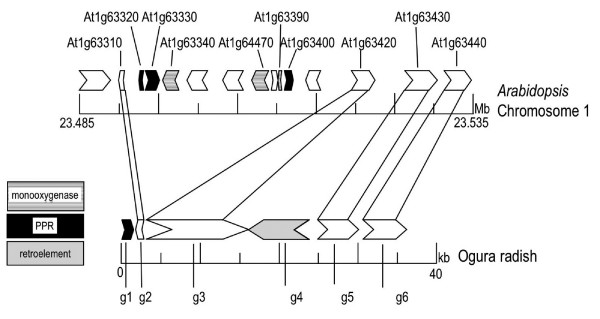
Predicted genes in radish and the syntenic segment of the Arabidopsis genome. Protein-coding sequences in the radish genome (bottom; as predicted by Genscan). Protein-coding sequences in the Arabidopsis genome reflect the Munich Information Center for Protein Sequences (MIPS) annotation. The direction of the arrows indicates the direction of transcription/translation. Dark filled arrows indicate PPR encoding sequences. Arrows with horizontal stripes indicated monooxygenase encoding genes. The gene g4, indicated with a grey filled arrow, encodes a non-LTR retroelement reverse transcriptase. Orthologous coding sequences in the two genomic sequences are indicated by connecting lines. Distances in megabasepairs in Arabidopsis are indicative of the location of sequences on chromosome 1.